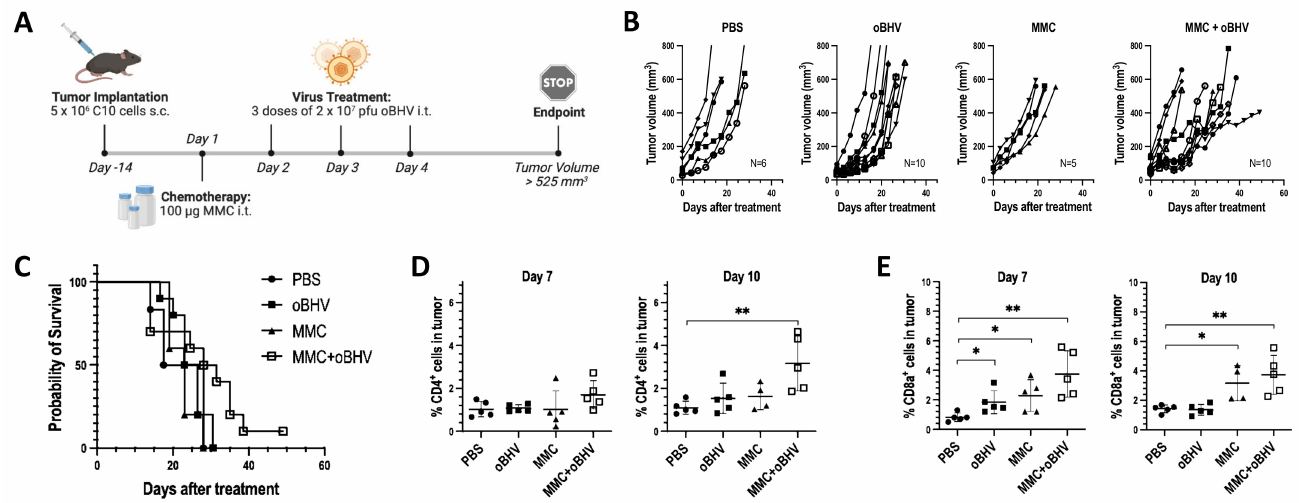
Figure 1. B16-C10 tumors were treated with PBS, oBHV, MMC or combination of MMC and oBHV (MMC + oBHV) ( A ). Tumors were measured every 3–4 days until animals reached endpoint. Tumor volume progression of each mice in each group ( B ) and Kaplan–Meier survival curve ( C ) are shown. Tumors were harvested on days 7 and 10 and histologic assessment with antibodies for CD4 and CD8a was performed to assess the level of T cell infiltration across the treatment groups. Quantification of CD4 ( D ) and CD8a ( E ) stains were performed over the whole tumor area. * p < 0.05 and ** p <